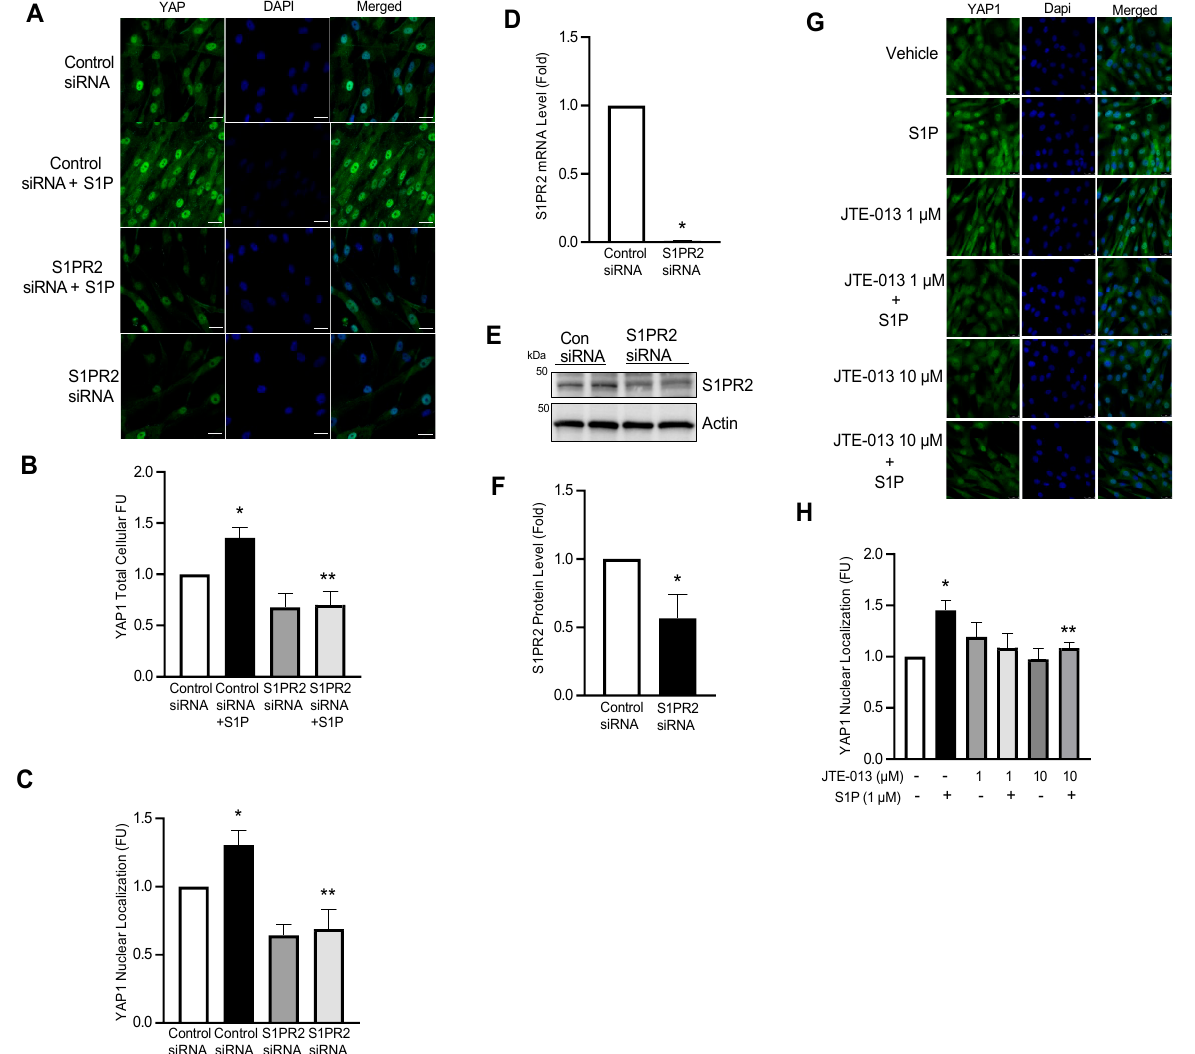
Figure 8. S1P promotes YAP1 nuclear translocation via ligation to S1PR2. hPASMCs were treated with control or S1PR2 siRNA (30 nM) for 72 h and then stimulated with S1P (1 µ M, 24 h). ( A – C ) Immunofluorescence staining of total cellular and nuclear YAP1 in hPASMCs and quantification data demonstrating that SIPR2 knockdown inhibits S1P-induced YAP1 expression and nuclear translocation; ( D ) real-time PCR showing decreased S1PR2 gene expression; ( E , F ) representative Western blot images and β -actin-normalized quantification of protein demonstrate that S1PR2 protein levels were significantly silenced by siRNA; ( G , H ) immunofluorescence staining and quantification data showing that the S1PR2 inhibitor JTE-013 (10 µ M, 1 h pretreatment) inhibits the S1P (1 µ M, 24 h)-induced nuclear localization of YAP1. n = 3; * p < 0.05 versus siRNA or vehicle control; ** p < 0.05 versus siRNA control or versus S1P alone. Scalebar: 25 µm.